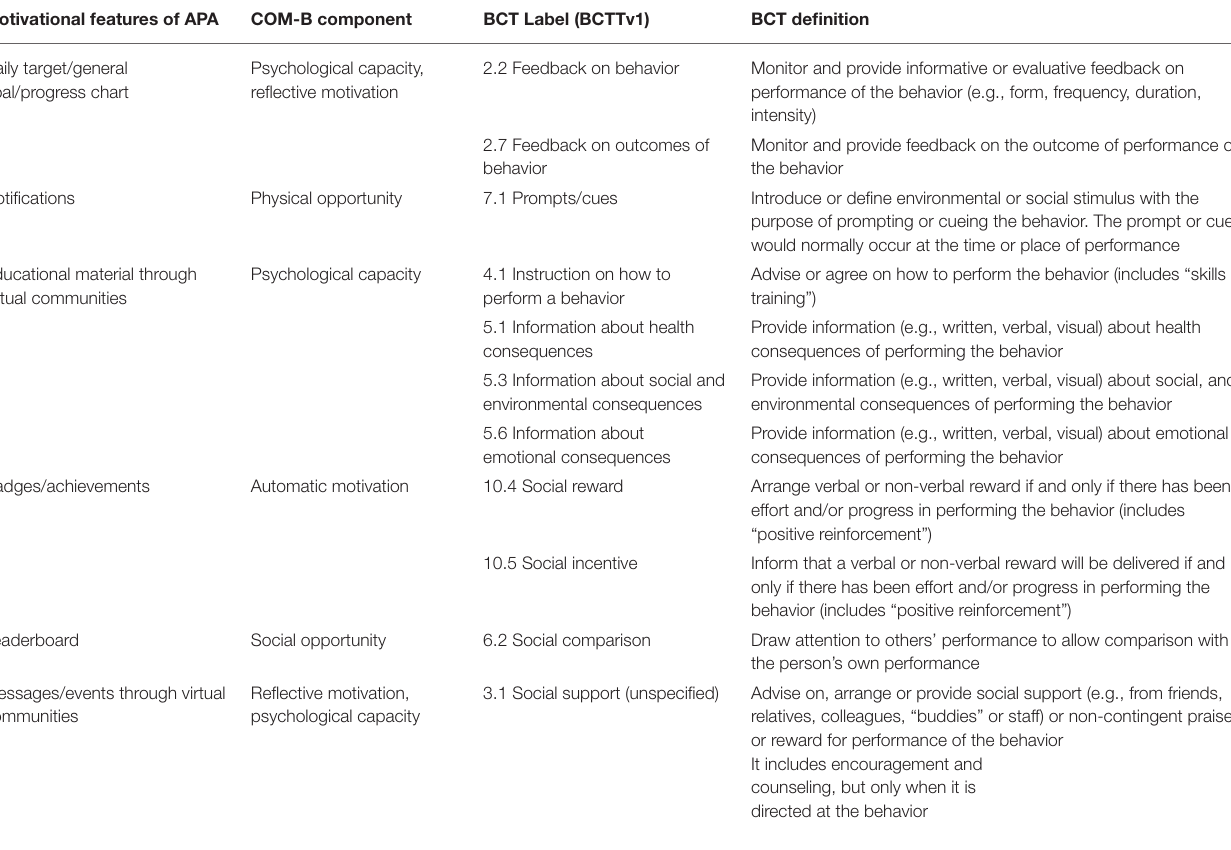
TABLE 1 | The motivational features of the application and their correspondence with the Behavioral Change Techniques Taxonomy (BCTTv1). Motivational features of